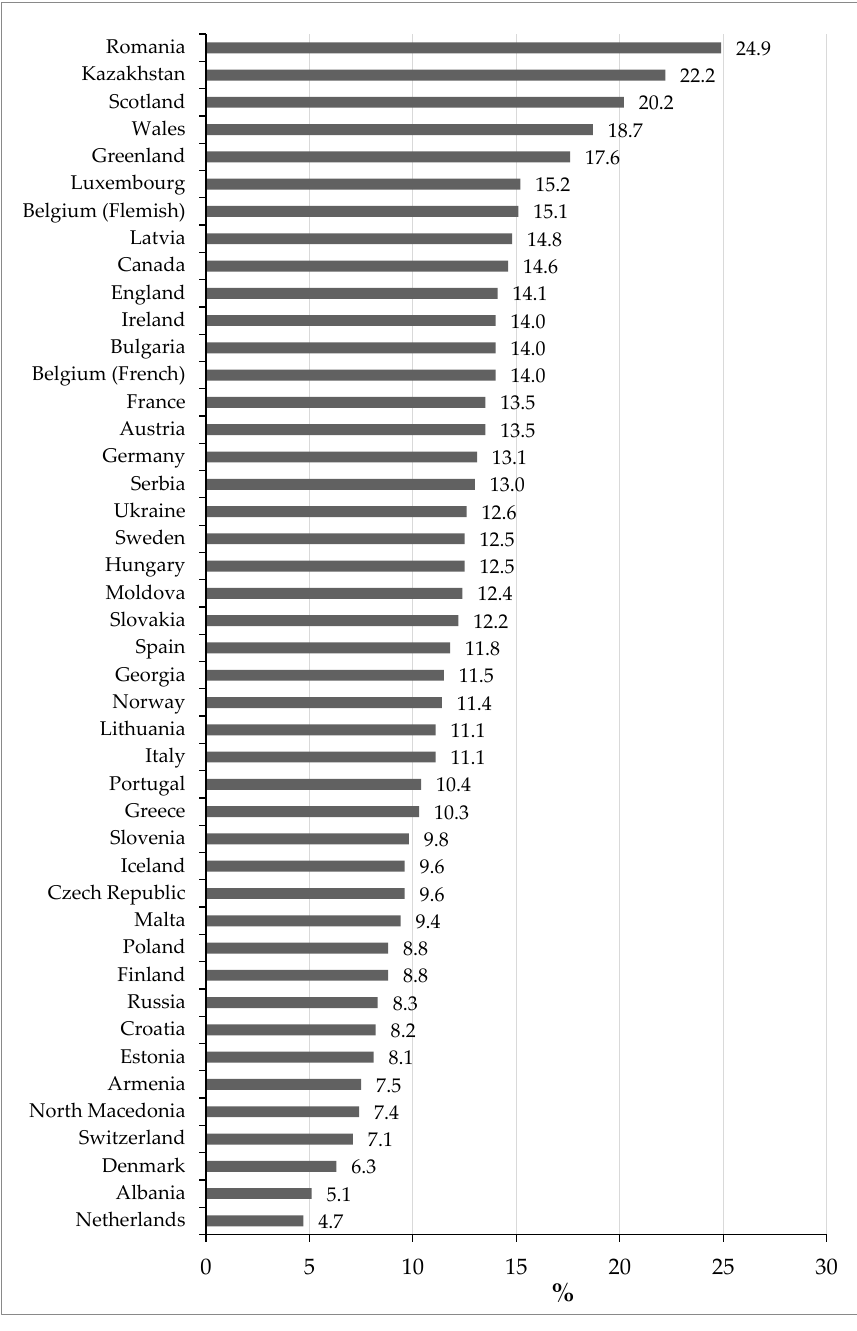
Figure 4. Proportion of single-mother families by HBSC countries in 2018. Table 1. Reasons given for not living with both parents in several countries.